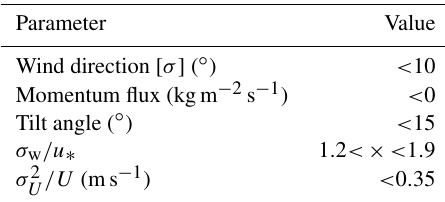
Table A2. Flux segment quality control